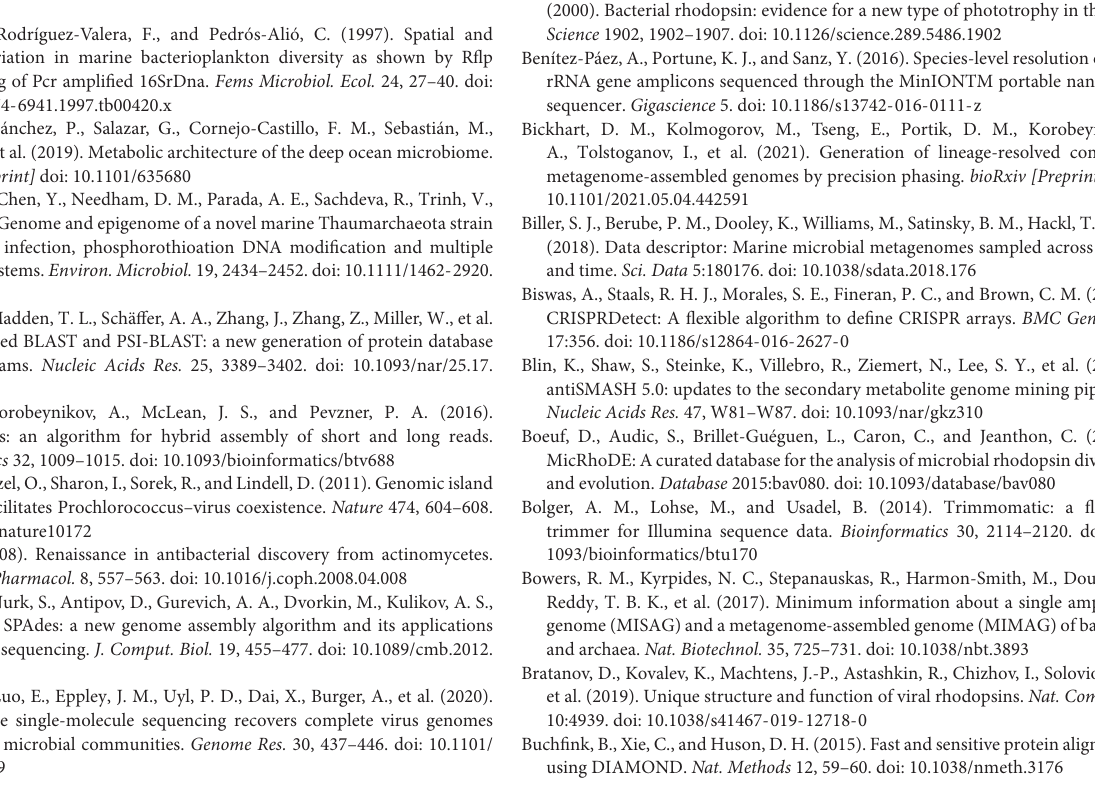
Supplementary Figure 1 | Comparison of the assembly size ( y -axis) versus the assembly of five subsets of PacBio Sequel II raw reads ( Supplementary Table 2 ). Linear trends ( y = mx + n ) are included for assemblers HiCanu and metaFlye. Supplementary Table 1 | NCBI Accession Numbers for picocyanobacterial ITS from reference genomes. Supplementary Table 2 | Relative abundance of 16S rRNA reads, based on the SILVA database. Supplementary Table 3 | Summary statistics of the assembly of PacBio raw reads using three assemblers (metaSPAdes, metaFlye, and HiCanu) and applying five read subsets.